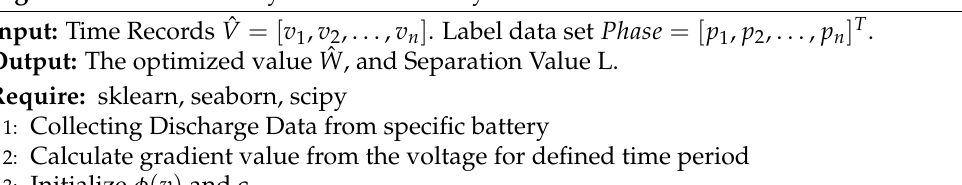
Algorithm 1 Li-ion battery SVM of this